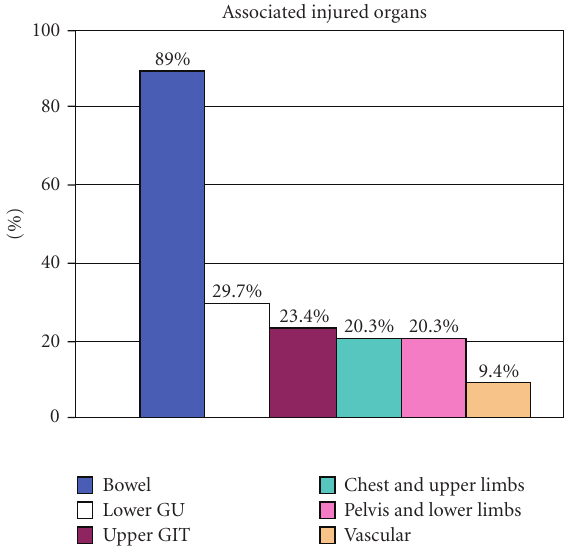
Figure 4: Concomitant injuries in 64 penetrating bladder injury patients.